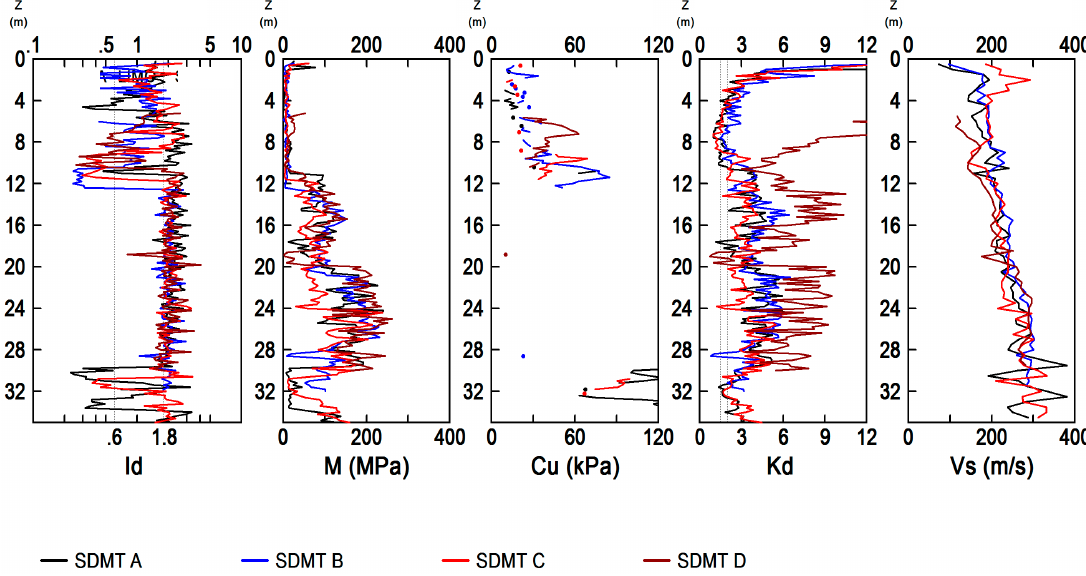
Figure 3. Summary of SDMTs in Scortichino—Bondeno area.